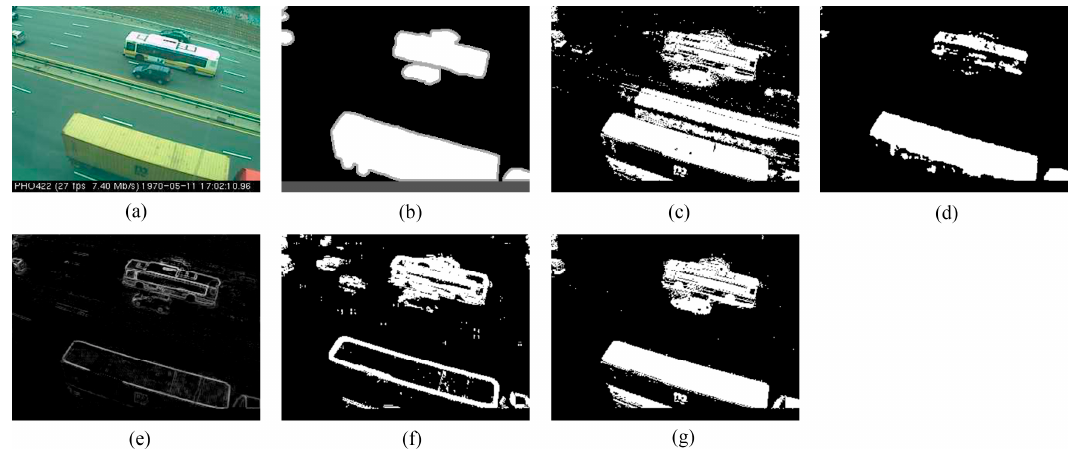
Figure 10. Detection results of the 90th frame of TC96 (Frame 502): ( a ) input frame; ( b ) ground-truth reference; ( c ) result of ViBe; ( d ) result of PCP; ( e ) result of TD-2DDFT; ( f ) result of TD-2DUWT; ( g ) result of TD-3DDWT.